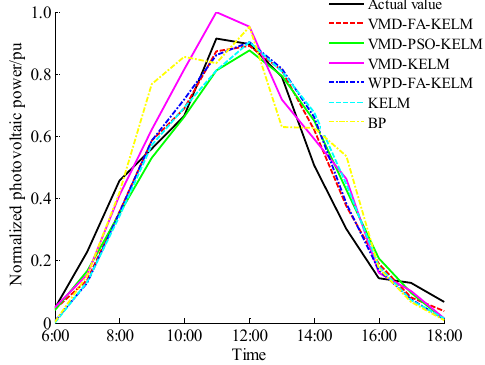
Energies 2019 , 12 , x FOR PEER REVIEW Figure 9. Point prediction of the cloudy day under different optimization algorithms.